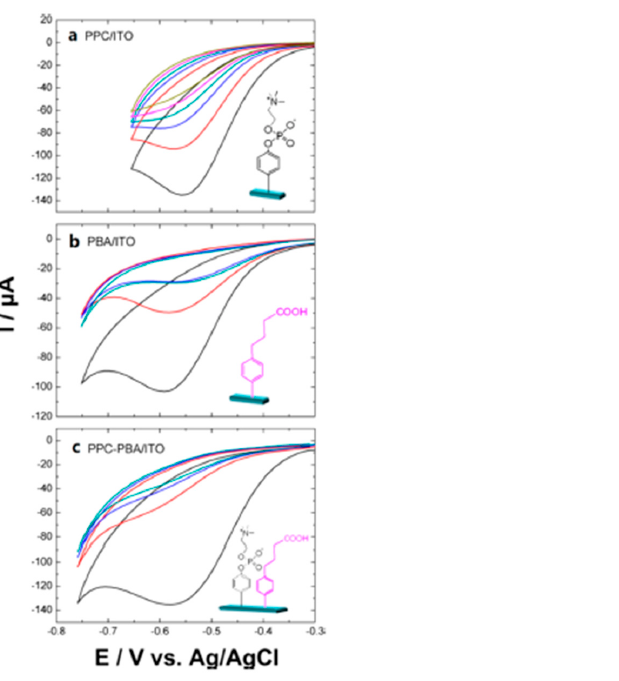
Figure 18. Cyclic voltammetry of the diazonium salts of 4-aminophenyl phosphorylcholine (PPC), 4-(4-aminophenyl) butyric acid (PBA), and their mixture on an indium tin oxide (ITO) electrode. From Reference [117] with permission of the American Chemical Society.